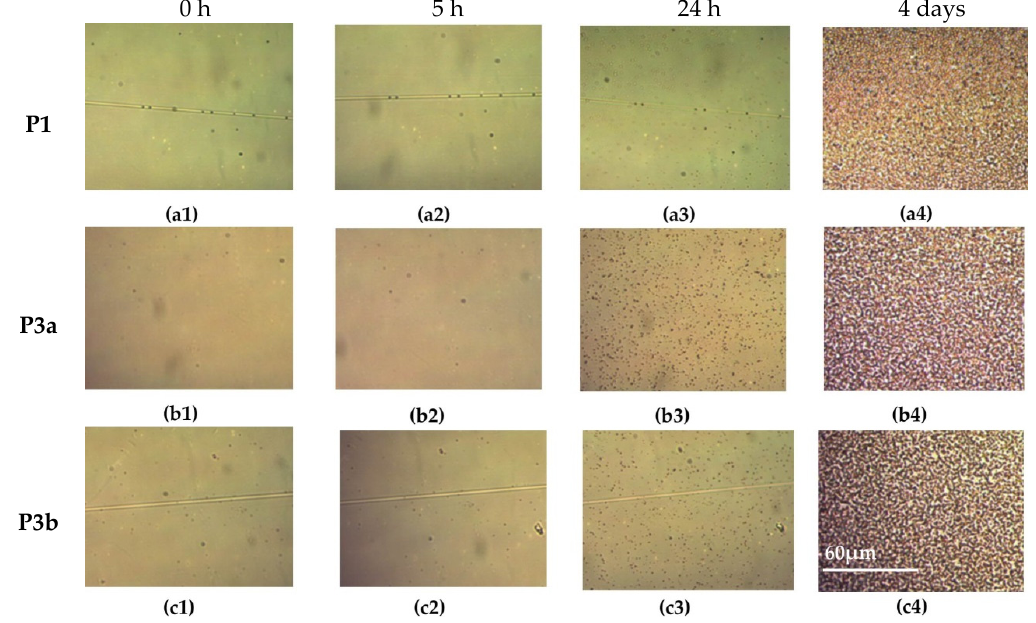
Figure 5. Optical microscope images (50× magnification) of the active layers of RC PSCs based on P1 ( a ), P3a ( b ) and P3b ( c ) after exposure to 85 °C for 0 h (1), 5 h (2), 24 h (3) and four days (4).